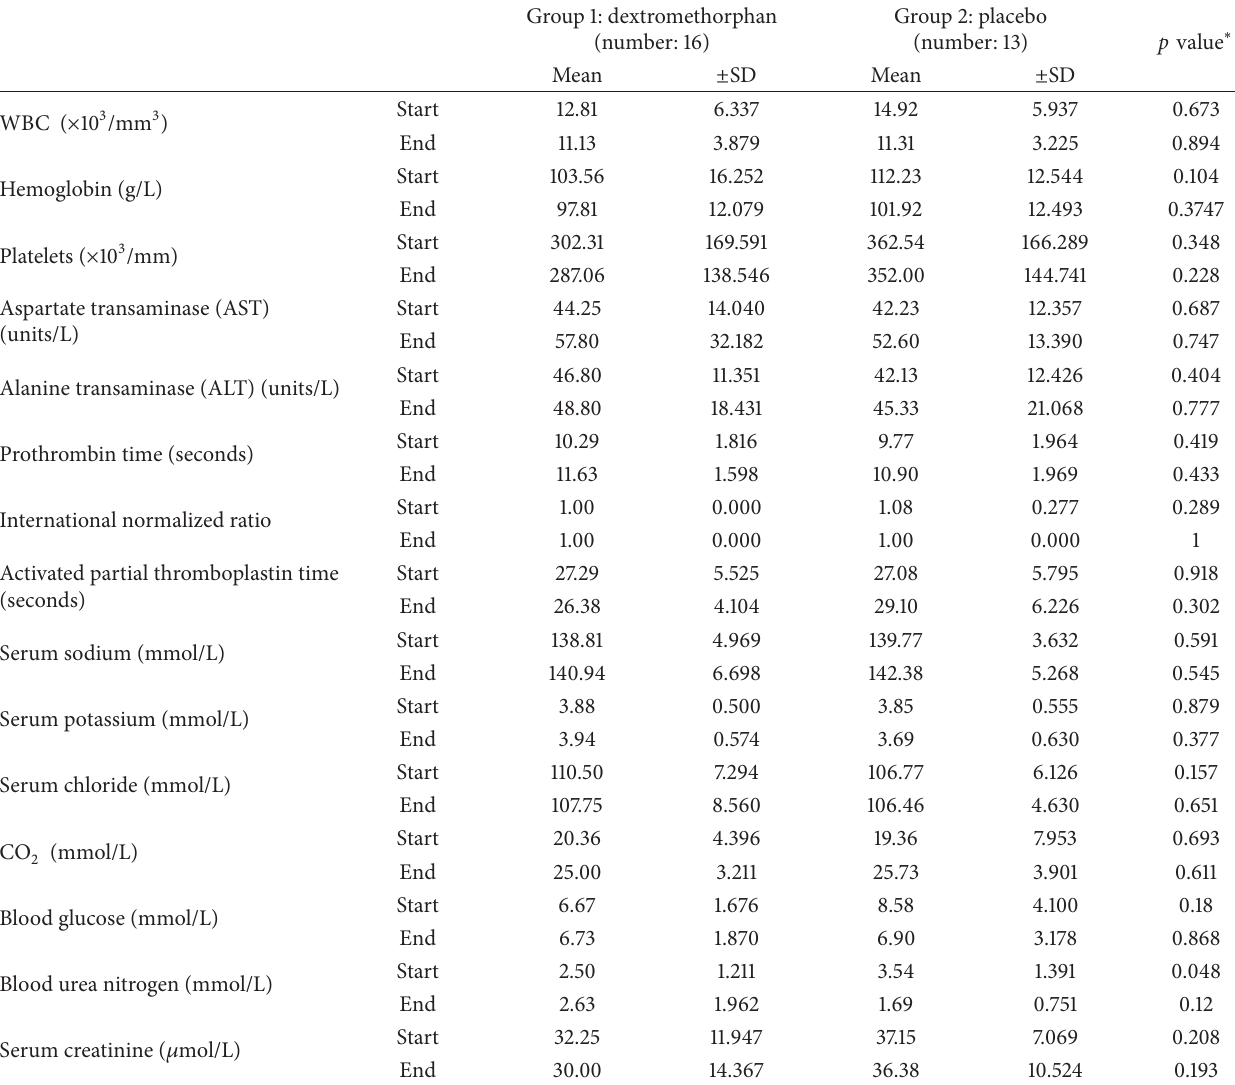
Table 2: Biochemical variables of subjects in groups 1 and 2 in RCT. Groups compared via Student’s t -test comparison of means. 𝑝 < 0.05 is significant. Values are expressed as mean and standard